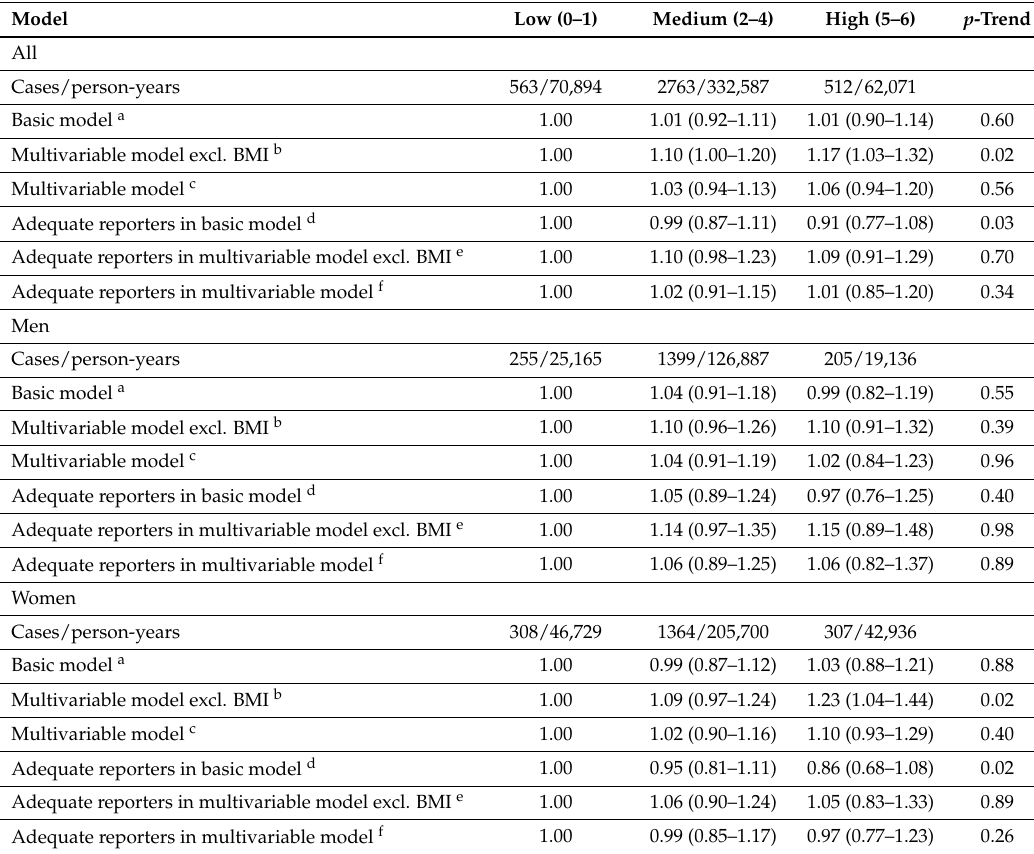
Table 2. Hazard ratio (HR) and 95% confidence interval (CI) for incident type 2 diabetes by categories of diet quality index score among men ( n = 10,413) and women ( n = 16,455) in the Malmö Diet and Cancer cohort (1991–2014).